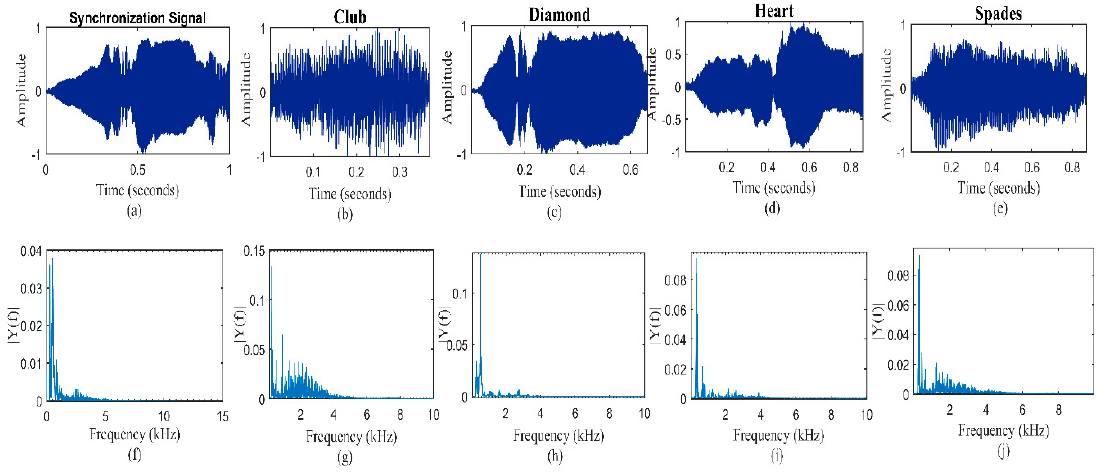
Figure 3. ( a ) Synchronization signal, ( b – e ) bionic Morse elements as club, diamond, heart and spades in time domain, and ( f ) shows single sided Fourier transform of synchronization signal and ( g – j ) bionic Morse elements respectively.